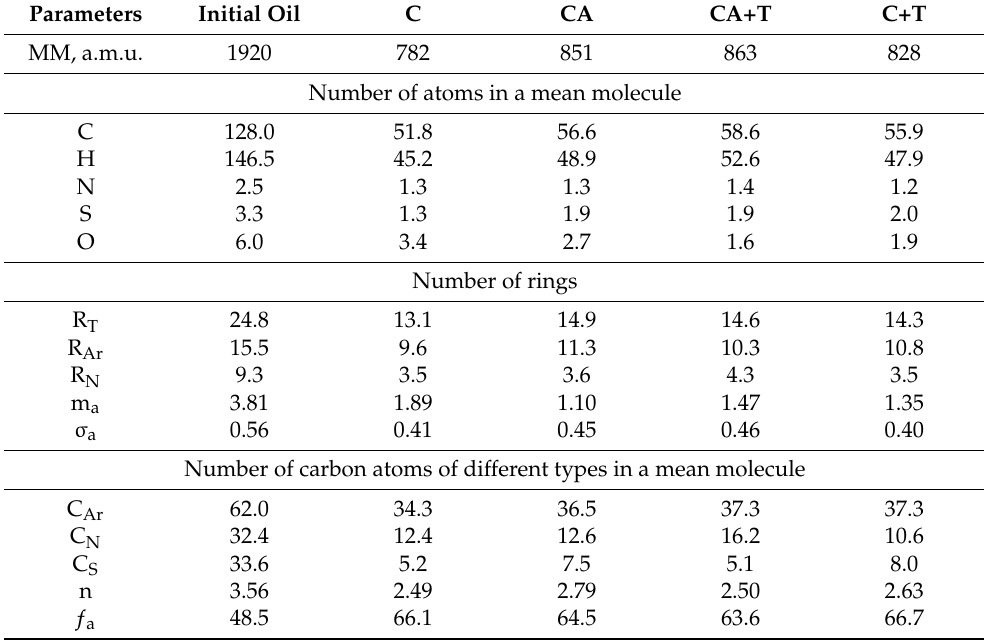
Table 3. Average physicochemical and structural parameters of the initial asphaltenes molecules and the products of non-catalytic and catalytic aquathermolysis.